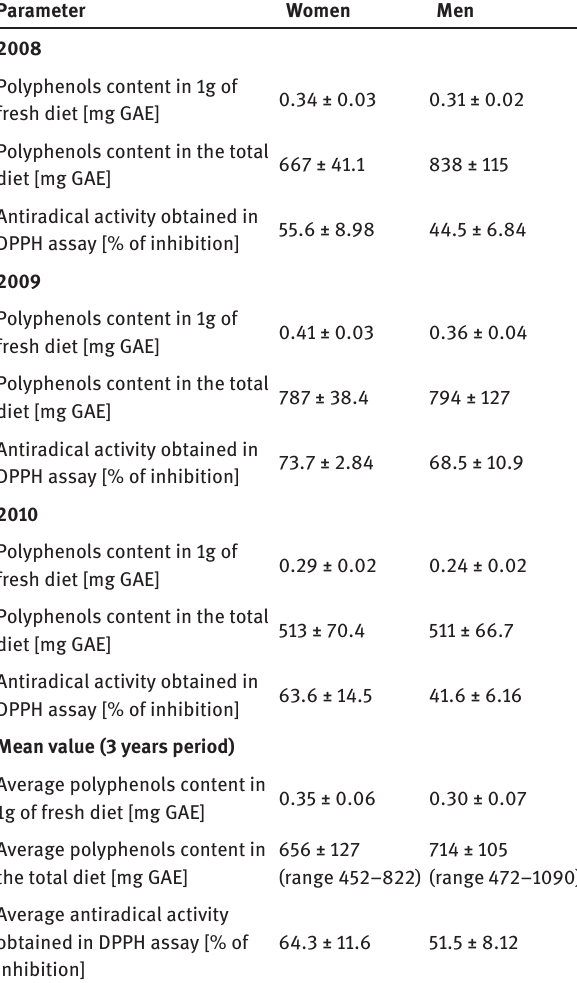
Table 3: Daily intake of food polyphenols and antiradical activity of diets among women and men from three universities in 2008, 2009 and